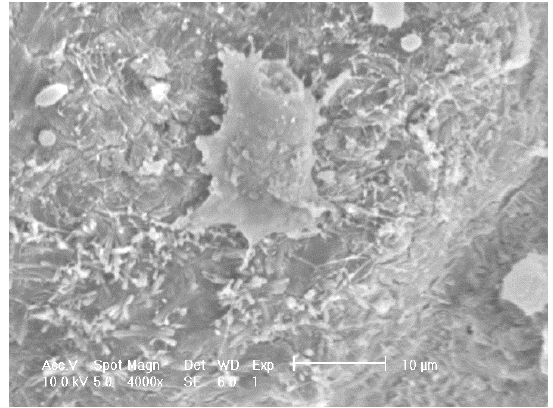
Figure 7. SEM images revealing the morphology of MG63 cells seeded on to porous alumina doped with